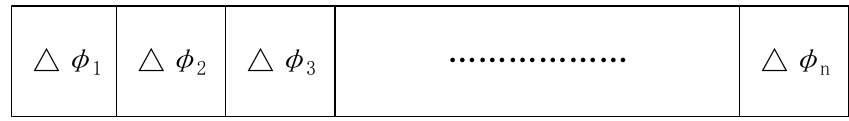
Figure 9. The encoding method of chromosome.